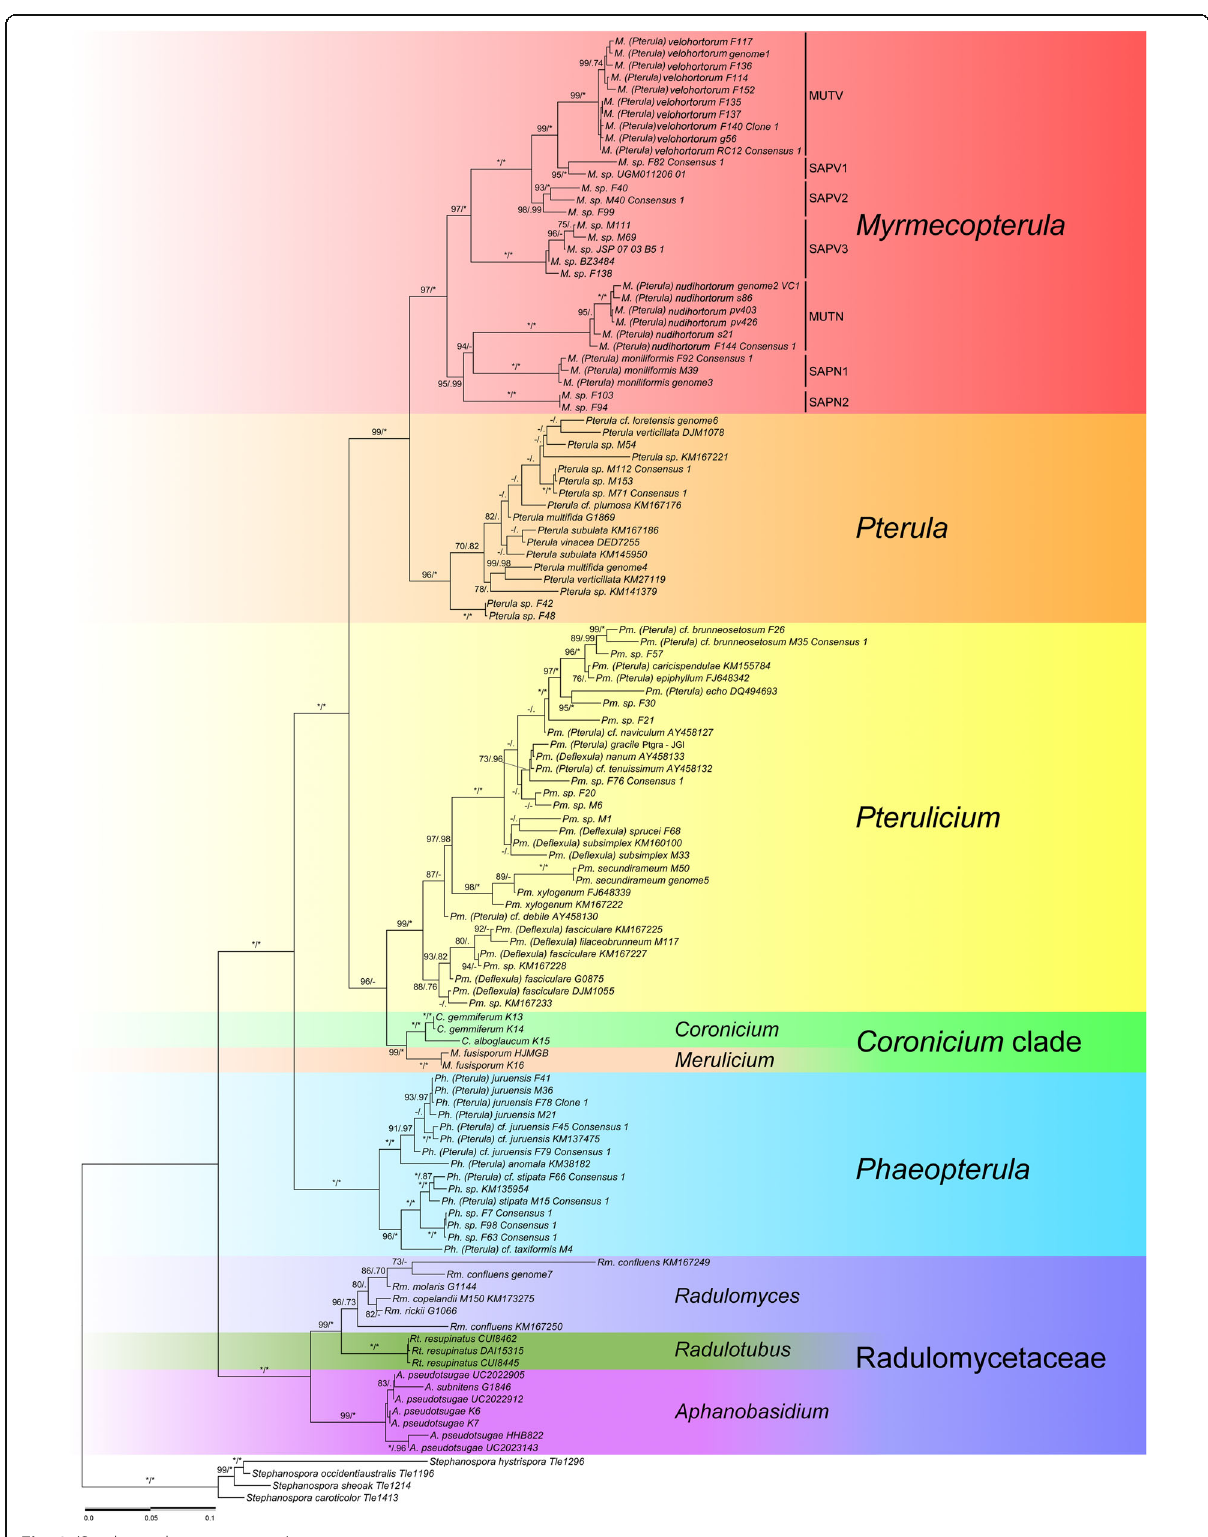
Fig. 3 (See legend on next